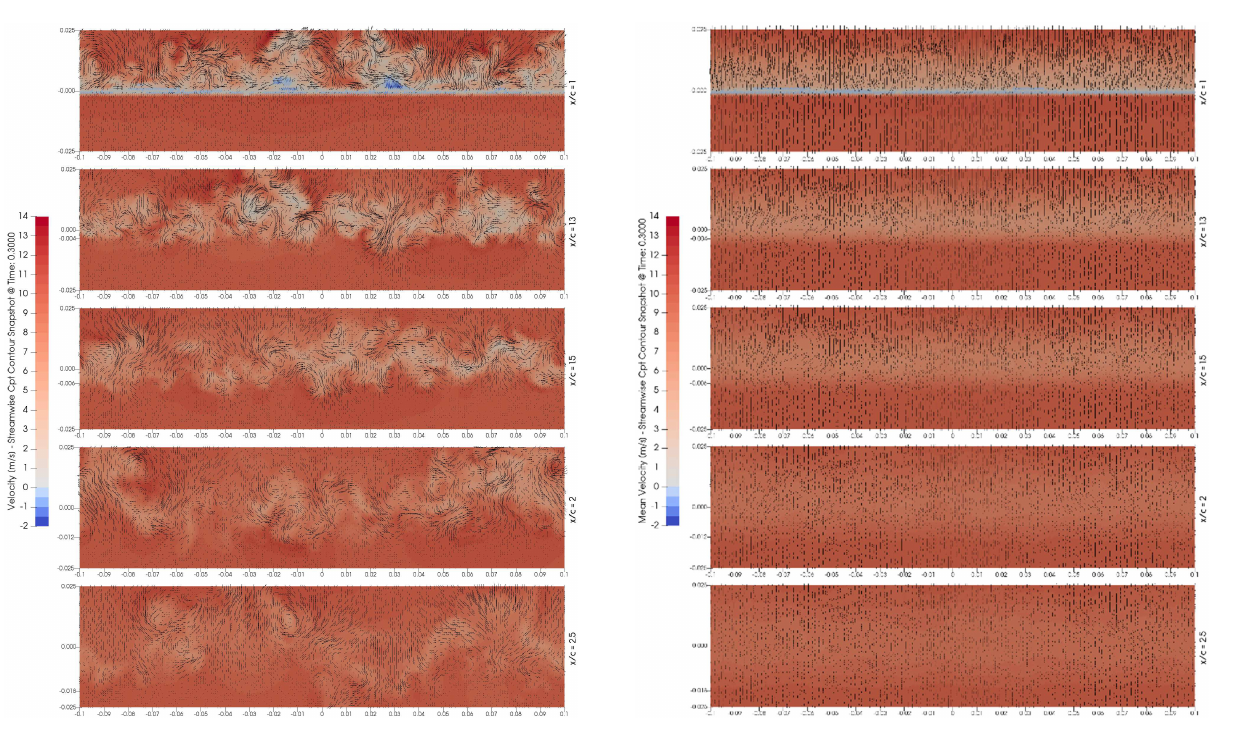
Fig. 13 . Streamwise normal planes above plate suction surface. mean spanwise velocity contours and vectors of mean in-plane velocity.